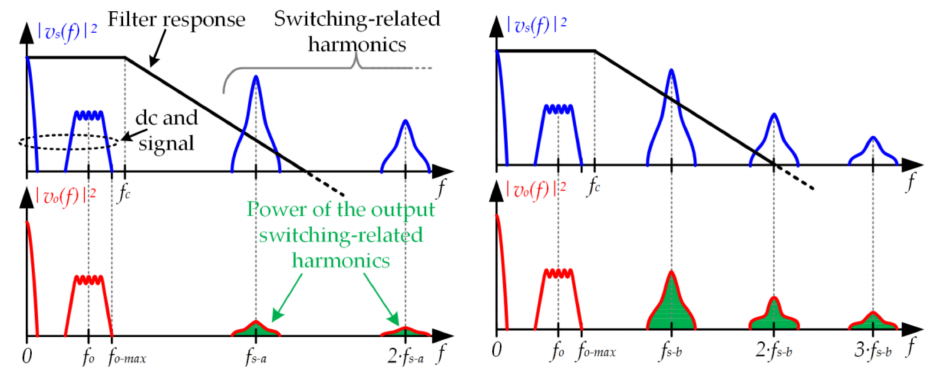
Figure 8. Analysis in the frequency domain of the distortion increase when f s is reduced ( f s-b < f s-a